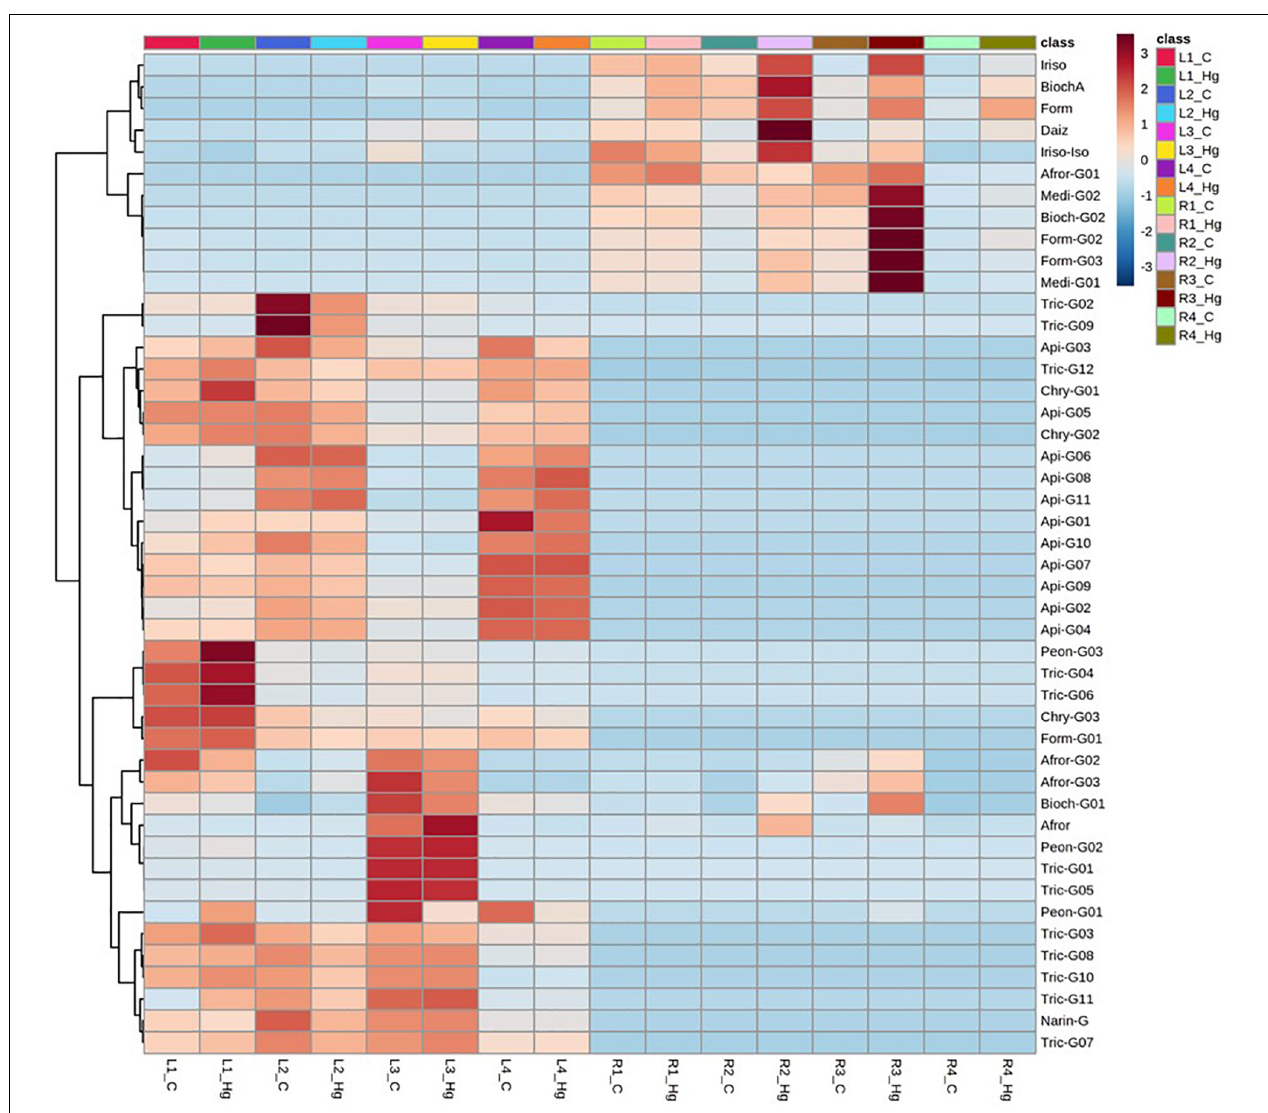
FIGURE 6 | Dendrogram and heatmap analysis of flavonoids and their glycoconjugates profiling in Medicago truncatula leaves (-L) and roots (-R) for control (C) and Hg-treated plants.